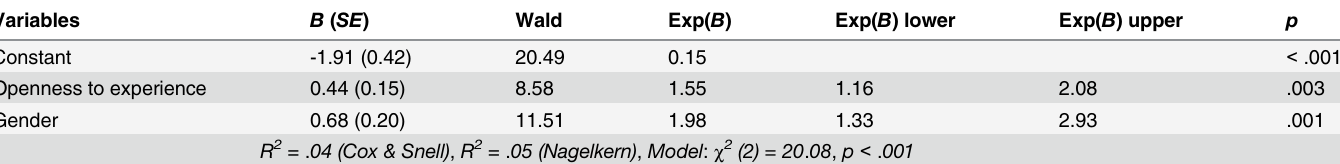
Table 5. Results of the binary logistic regression with simultaneous entry (SE in